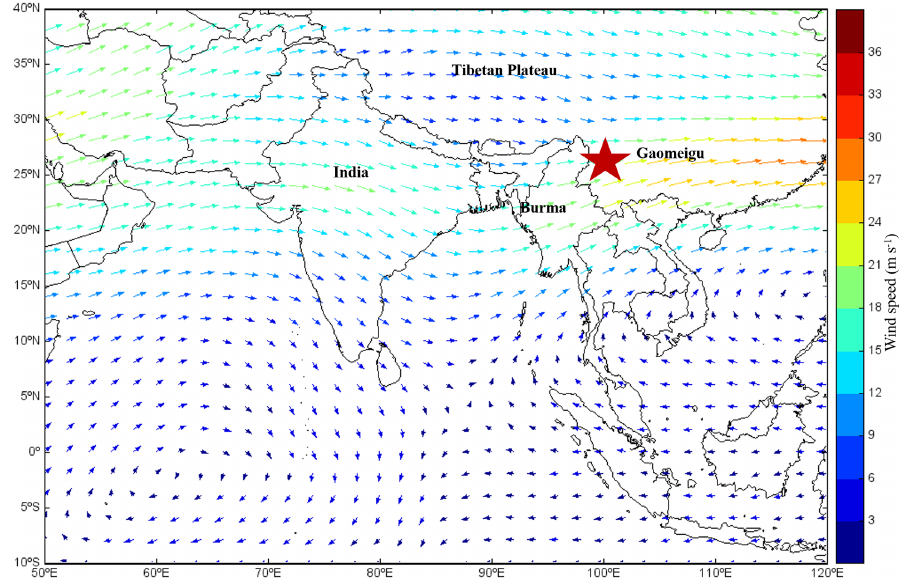
Figure 1. Location of the Gaomeigu sampling site (red star) on the southeastern margin of the Tibetan Plateau and prevailing wind during sampling